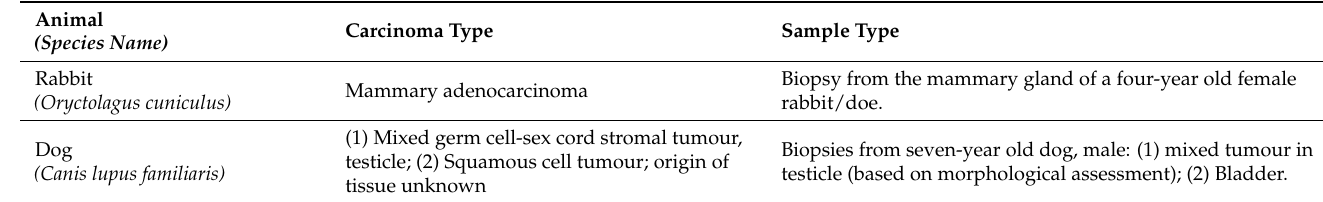
Table 2. Overview of the 20 different cancer samples assessed from 12 different animal species in the current pilot study. Animal species name, cancer type, and further information on the samples are